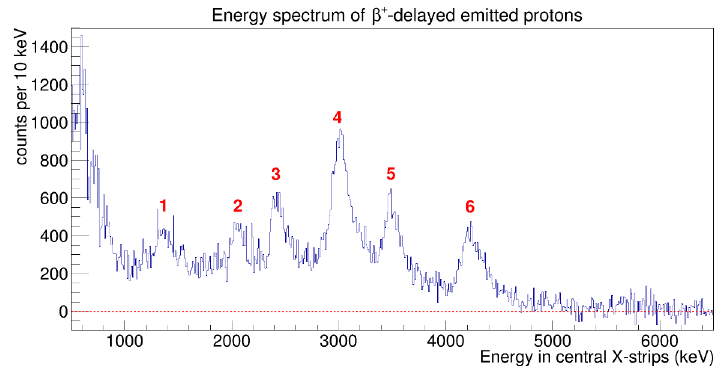
Figure 3. Sum-of-the-energy spectrum of the charged particles emitted after the 46 Mn β + decay for the central implantation pixels of the DSSSD. The red numbers list the proton peaks as they appear in the figure 22(b) of [7] Only the peaks 2, 4, 5, and 6 have an energy level assigned to them, while the peak 2 is associated with the decay of 45 Cr. The peaks 4-6 are assigned to the decay of the IAS to 45 V 4 th , and 5 th excited states, and to the ground state respectively.